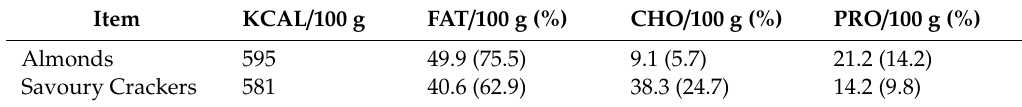
Table 1. Nutritional composition of the almond (based on Atwater values) and comparator snack. Item KCAL / 100 g FAT / 100 g (%)